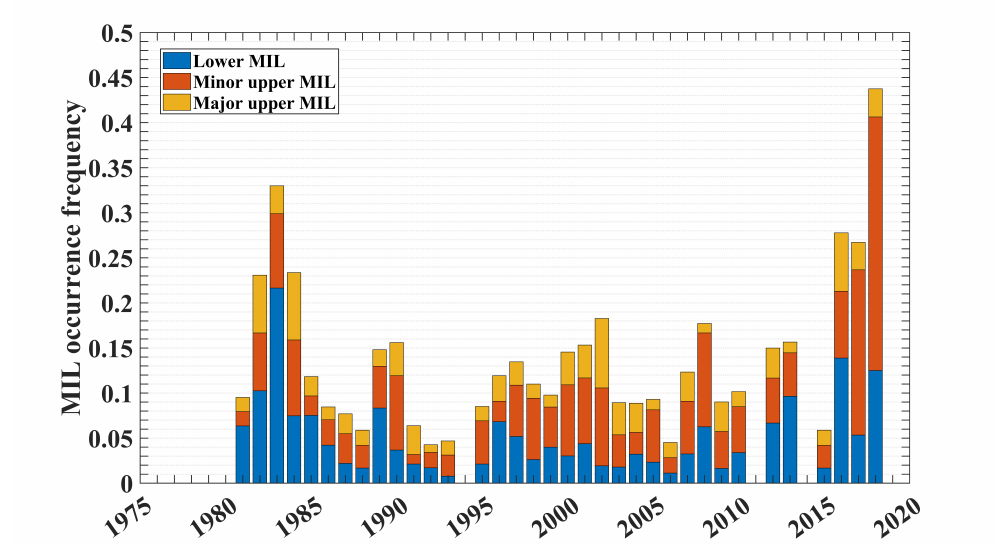
Figure 6. Annual histogram of the MIL occurrence frequency from 1978 to 2019. Table 3. Average values of MIL characteristics separately for each cluster group,